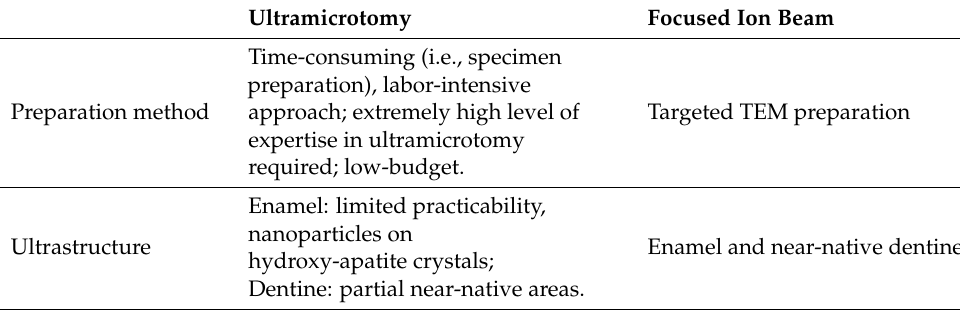
Table 1. Comparison of the TEM preparation methods, ultramicrotomy and focused ion beam, on human mature mineralized enamel and